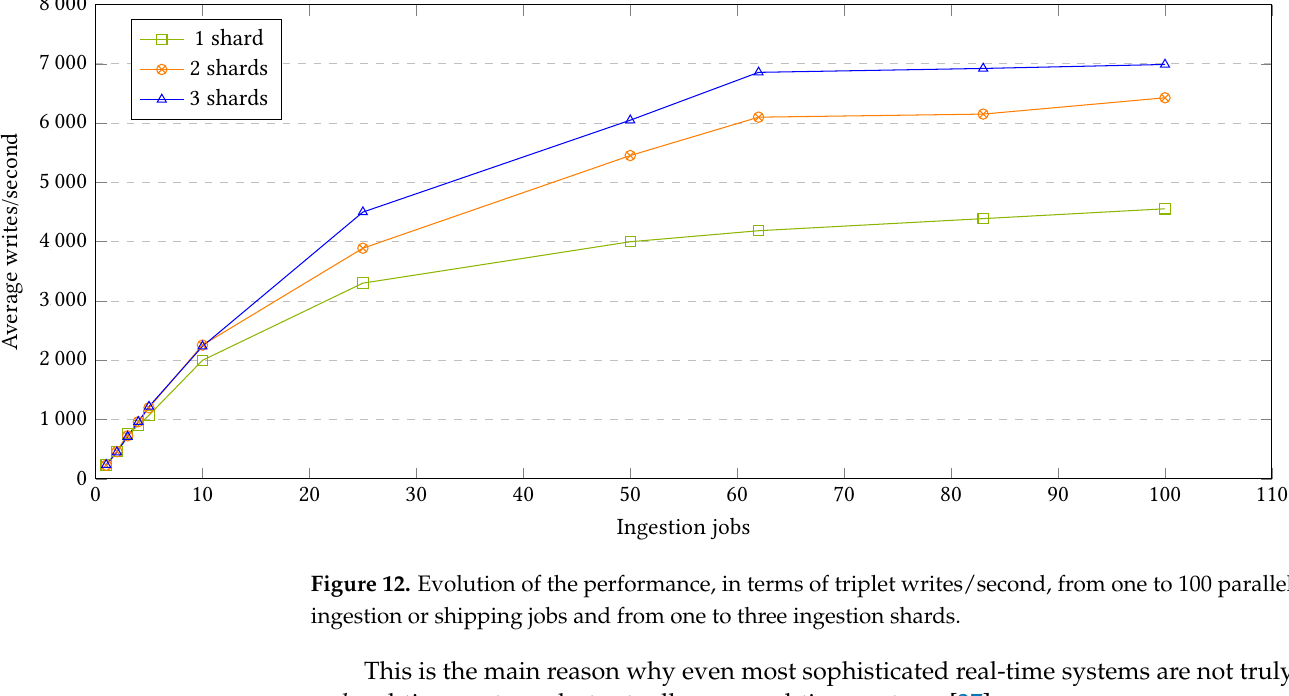
Figure 6: Scalability of the proposed approach with one to three ingestion nodes, and from 1 to 25 ingestion jobs, in a row-shipping fashion.